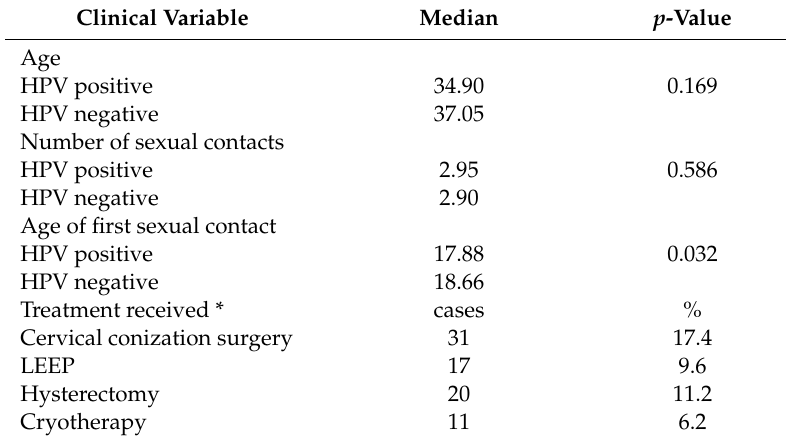
Table 1. Gynecological